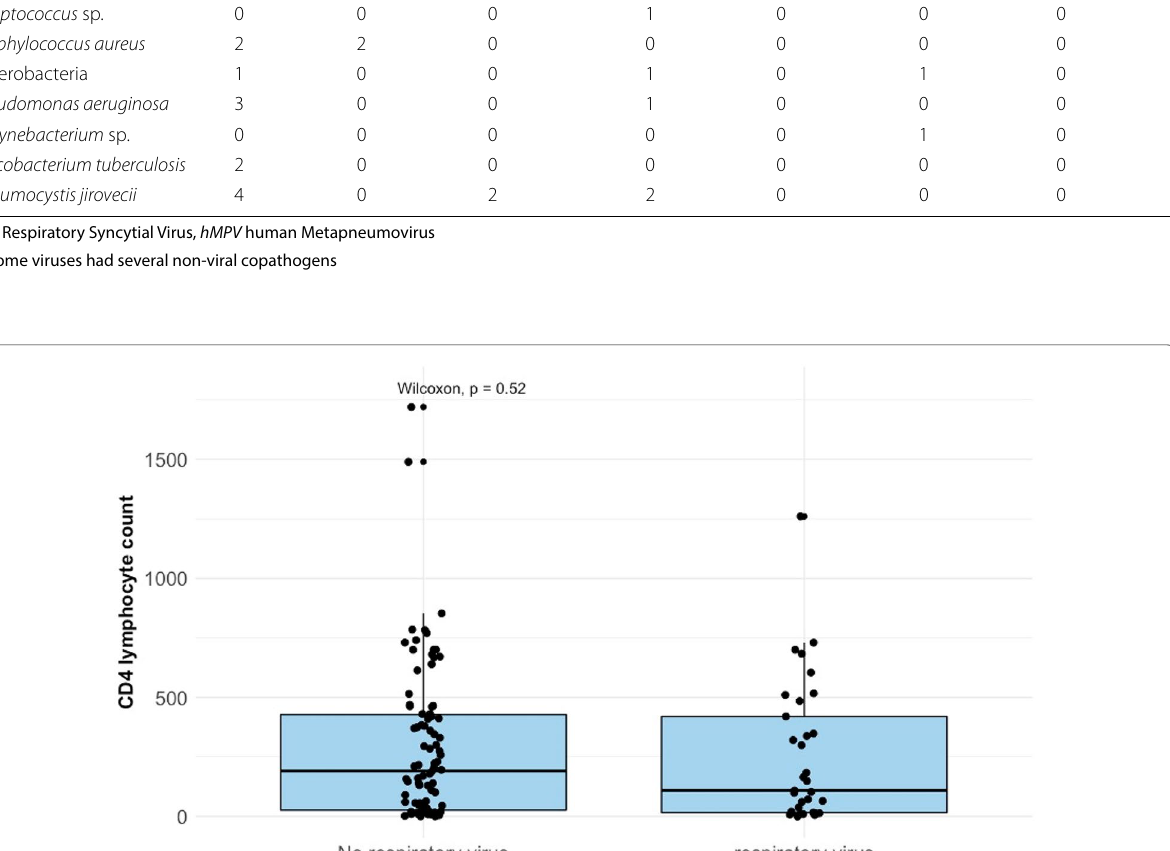
tory virus-associated infection, outcome was similar between infected and non-infected patients (Additional file 1: Table S3). In multivariate analysis, a respiratory virus-associated infection was not identified as an inde- pendent factor of either a complicated course (Table 5) or death at Day-28 (Additional file 1: Table S4).